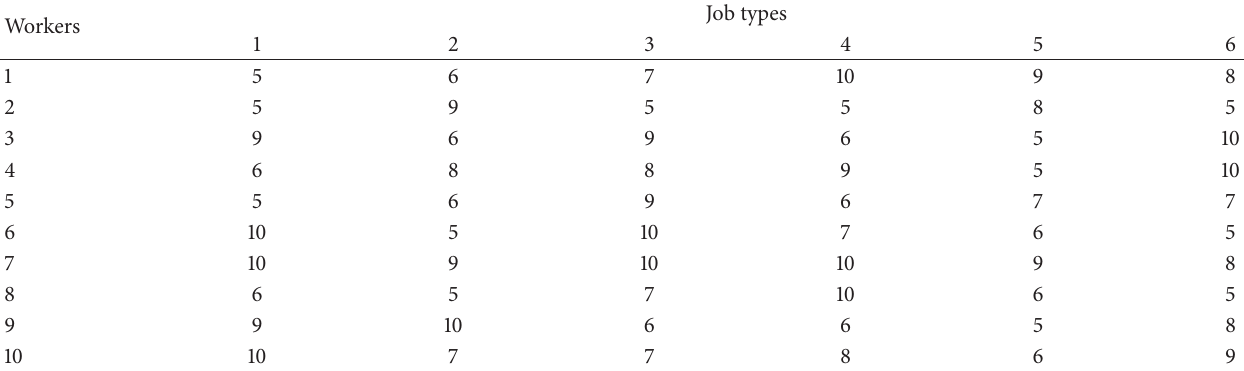
Table 8: The data of workers’ level of skill before training the workers ( 𝛽 𝑛𝑖 ).